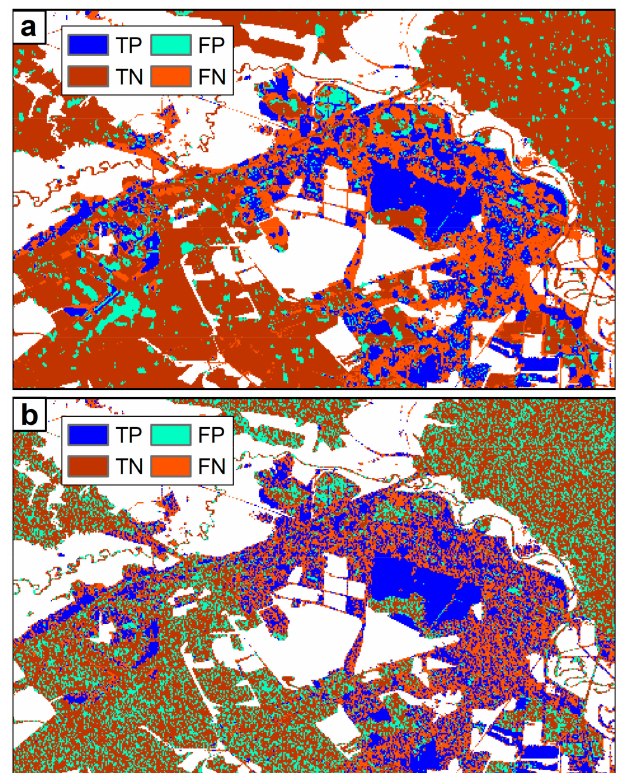
Figure 7. Comparison between ( a ) the contingency map obtained by p = 0.5 cuto ff threshold and ( b ) the contingency map from the best result of grid search on log intensity ratio of during- and pre-event image (i.e., nontemporal analysis). Pixels in the Uncertain class are masked out from the map.